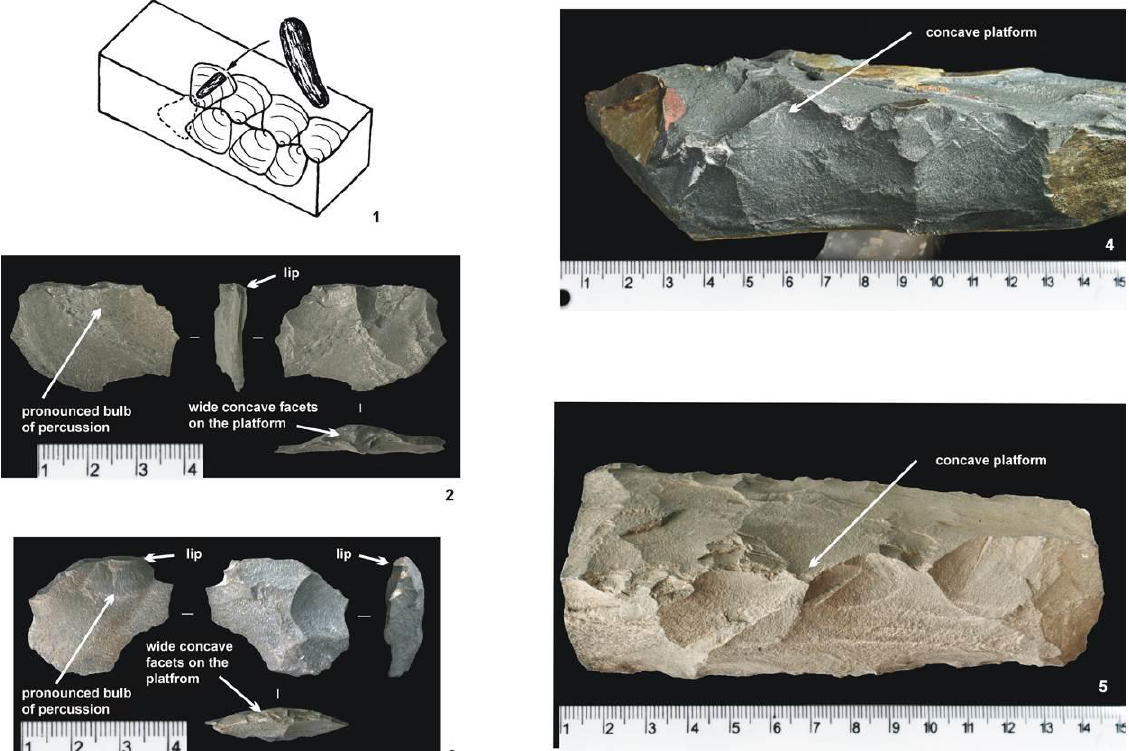
Figure 5. Technology of Russian Karelian tools. Punch technique and features of debitage resulting from its use. 1 - the method of using punch technique, 2 – an experimental flake, 3 – a flake from Fofanovo 13 assemblage, 4 – an experimental preform, 5 – a preform from Fofanovo 13 assemblage. 2-5 –